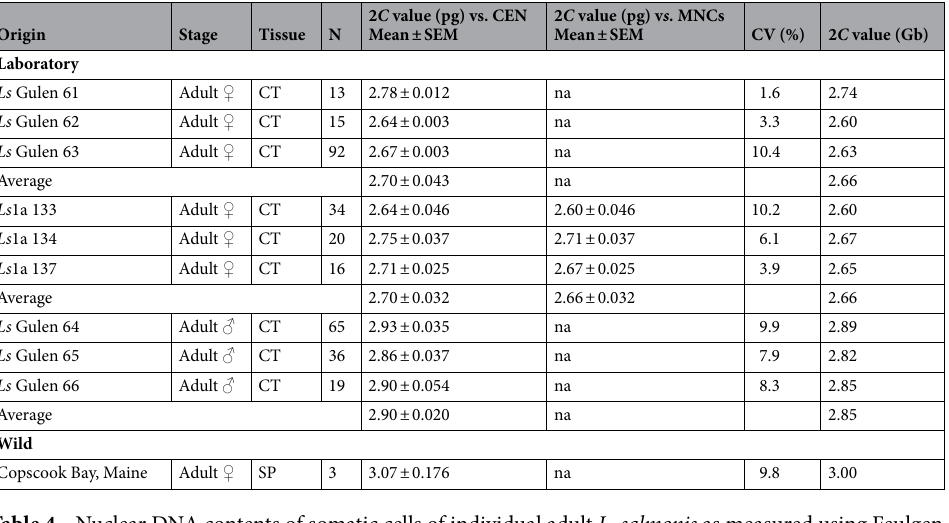
Table 4. Nuclear DNA contents of somatic cells of individual adult L. salmonis as measured using Feulgen image analysis densitometry. Cephalothorax (CT) tissues of laboratory reared adults were obtained from the Ls Gulen and Ls 1a populations. Tissue from the spine of an appendage (SP) was obtained from a wild caught Maine population. Hen (CEN) and male human mononucleated leucocytes (MNCs) were used as internal reference standards to estimate values in picograms (pg). Values based on hen were converted to gigabases (Gb). N refers to number of nuclei measured in each adult. SEM refers to standard error of the mean; CV refers to coefficient of variation of IOD